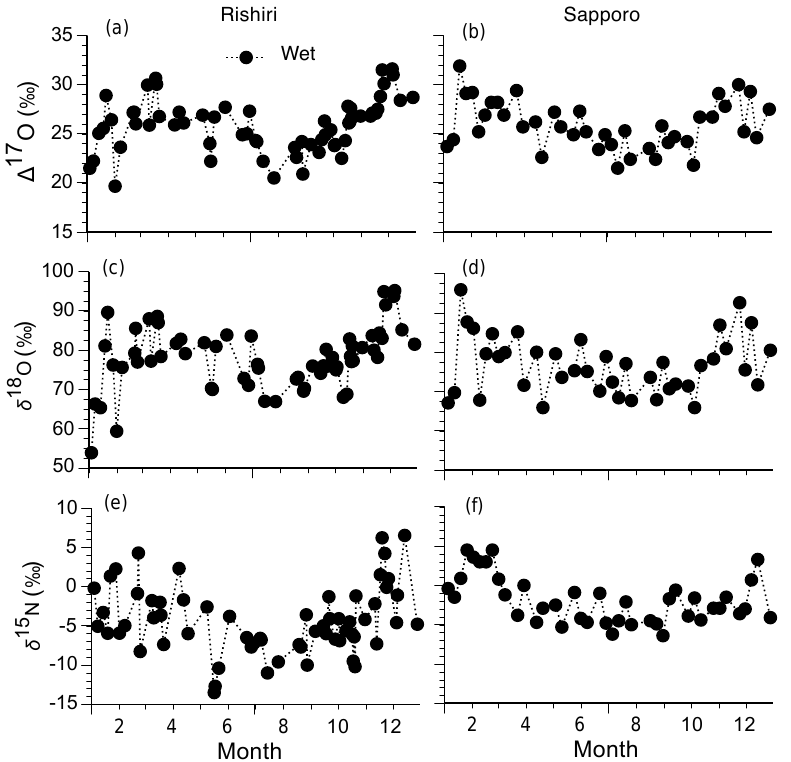
Figure 4. Time series of (a, b) (cid:49) 17 O values of nitrate in wet deposition, (c, d) δ 18 O values of nitrate in wet deposition, and (e, f) δ 15 N values of nitrate in wet deposition. Data from Rishiri (rural) are in left column and data from Sapporo (urban) are in right column.